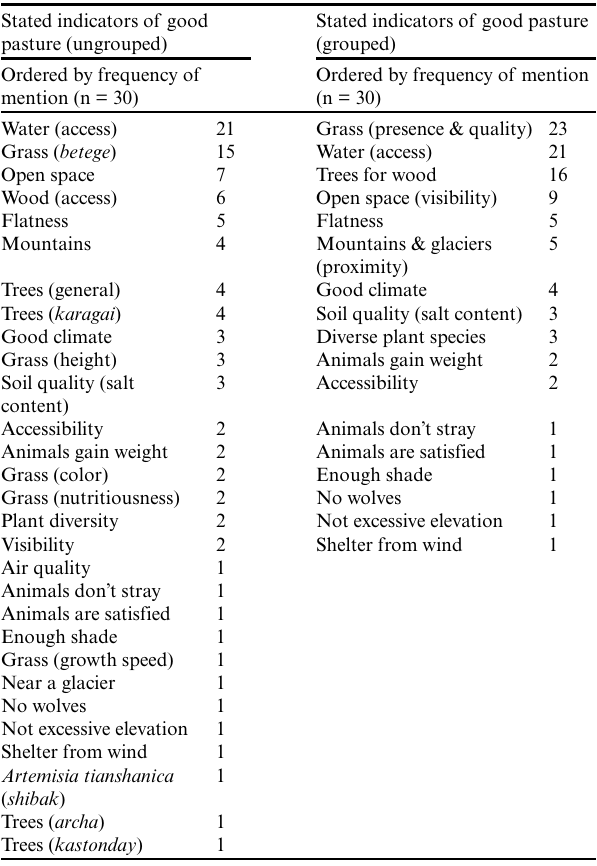
Table 1 . Free list of desirable pasture-site indicators: results. Stated indicators of good pasture (ungrouped) Ordered by frequency of mention (n = 30)